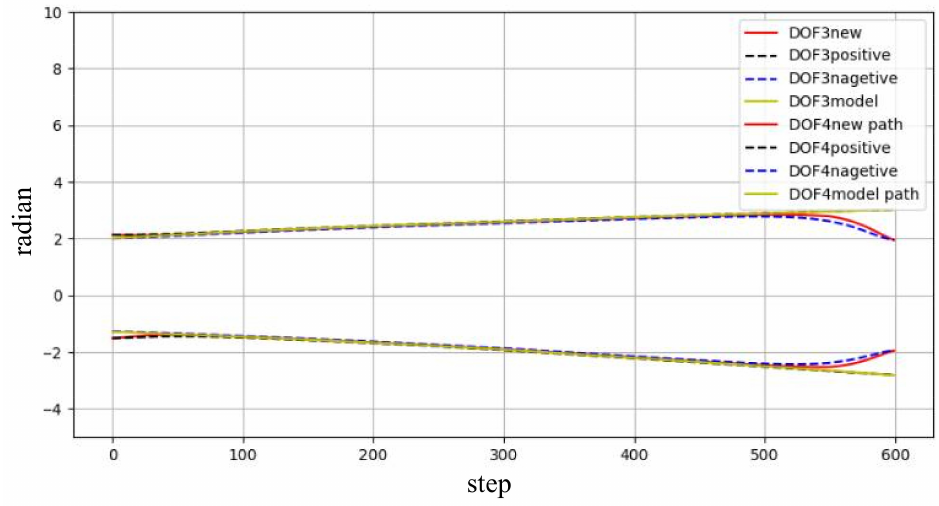
Figure 16. The effect of path